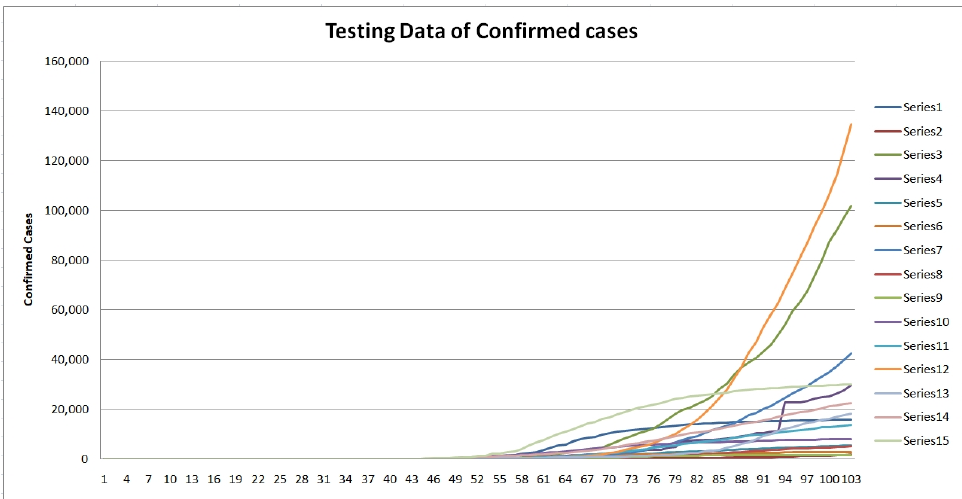
Figure 11. Testing dataset of confirmed cases for the 15 countries (1 April 2020 to 12 July 2020).